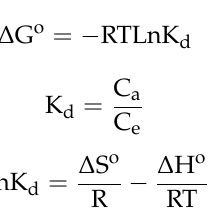
Figure 6. Effect of temperature on the removal efficiency of MB using MNS-4 (C i = 2000 ppm, m adsorbent = 1 g, contact time = 30 min, pH = 11).